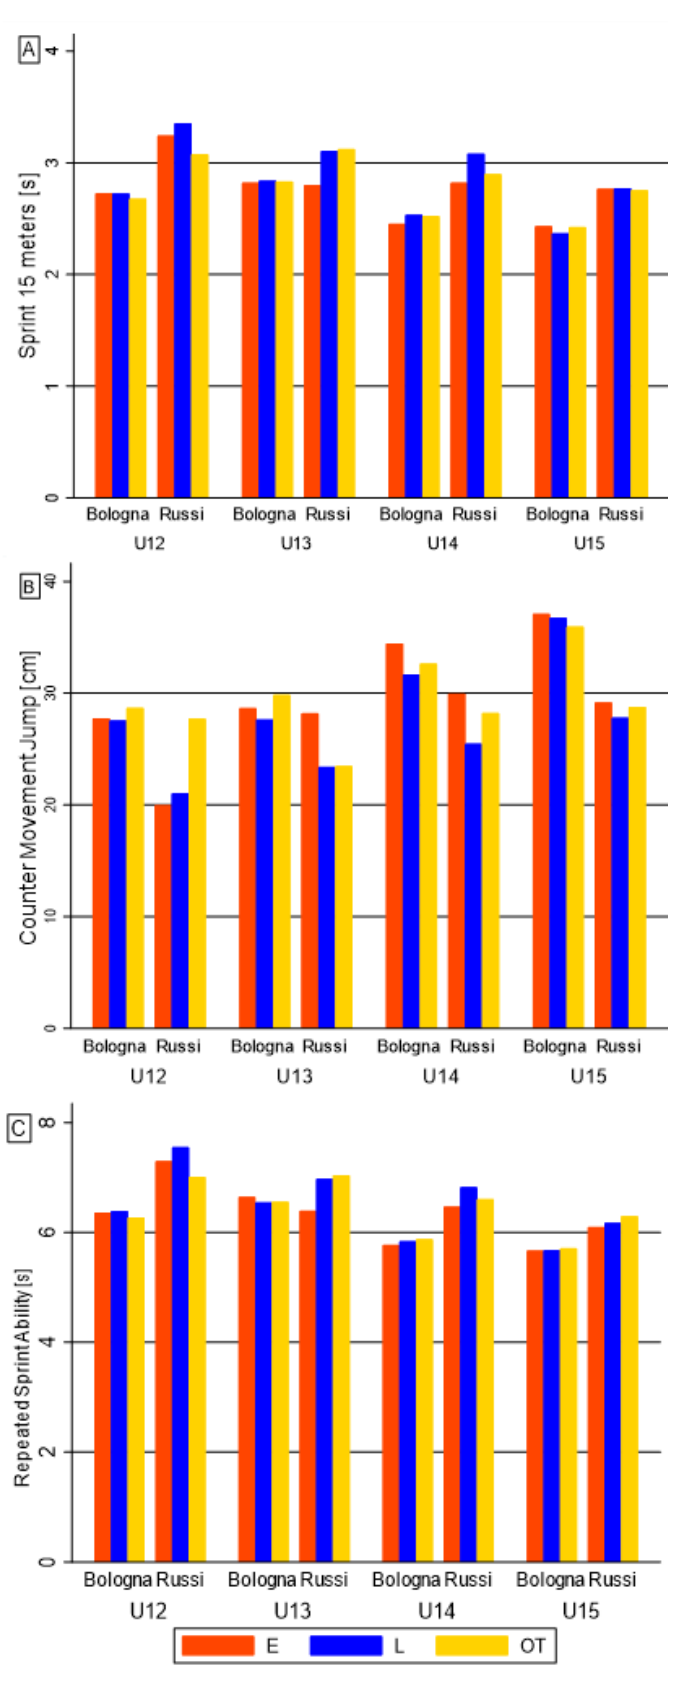
Figure 2. Bar graph of the maturity status effect on performance competition level discriminants, among teams and categories: ( A ) 15-meters sprint; ( B ) CMJ; ( C ) RSA.